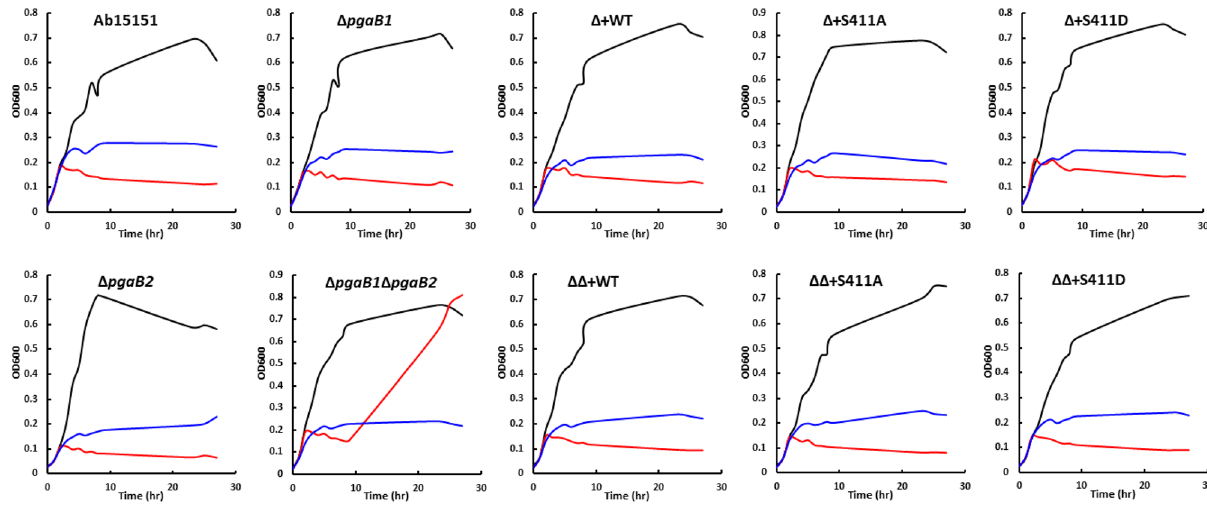
Figure 5. Time-dependent killing assays of WT and PgaB-mediated A. baumannii mutant strains demonstrated its colistin tolerance. In this study, the overnight cultures of A. baumannii strains were diluted to OD 600 0.05 for growth curve determination. The antibiotic colistin (red) and tetracycline (blue) were administrated with the final concentration of 16.0 µg/mL after 2 h incubation. During 27 h incubation, the optical density of each culture was determined at 600 nm by a microplate reader. The growth curve drawn in black was the condition without antibiotic administration as a